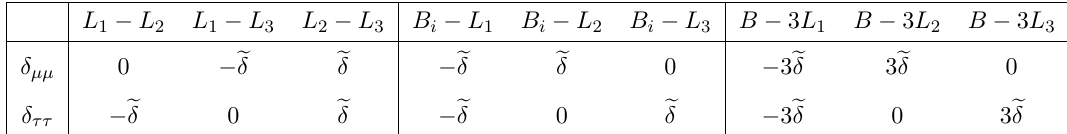
Table 1 . Expressions for (cid:14) ‘‘ (cid:17) ((cid:0) = (cid:0) ) (cid:0) 1 at one-loop level. Z ! ‘ + ‘ (cid:0) Z ! e + e (cid:0) universality test in the Z and (cid:28)=(cid:22) decays, LEP, BaBar and LHC searches, and neutrino trident and Z ! 4 (cid:22) production searches, we investigated phenomenological implications of the (cid:13)avored gauge boson Z 0 and put various